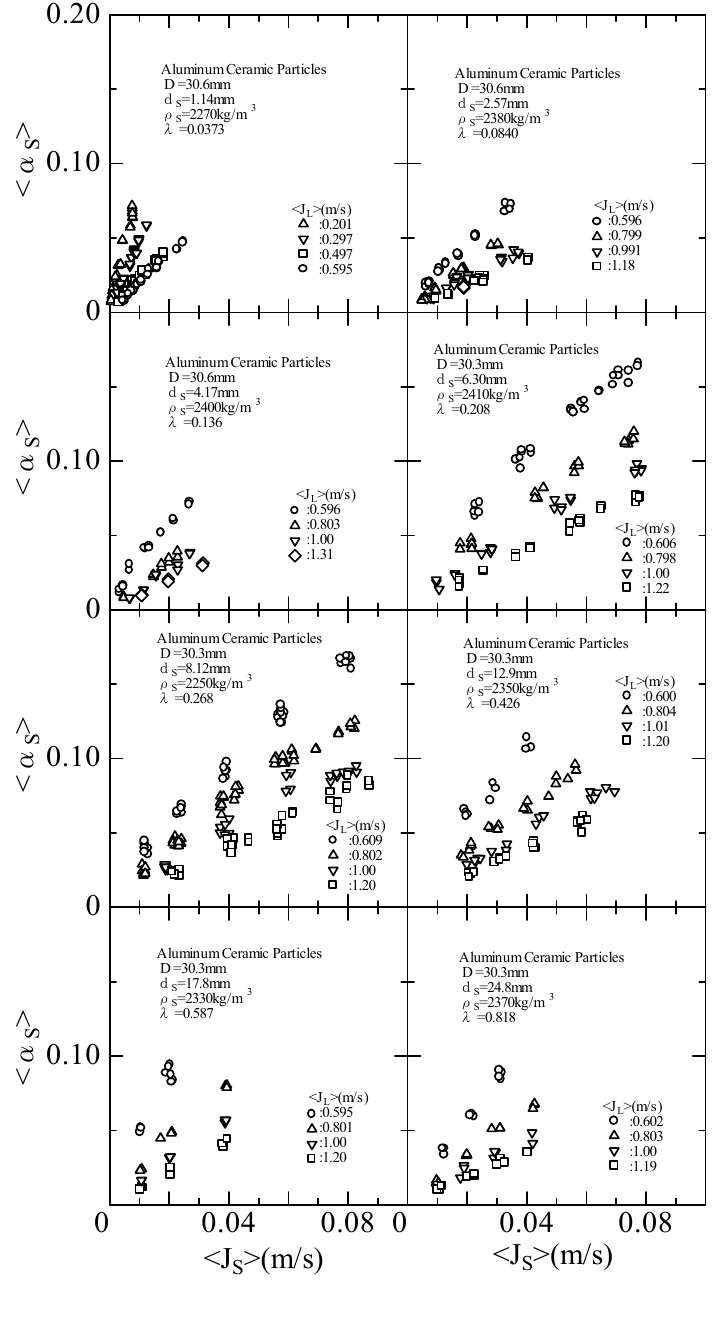
Fig.1 Solid volume fraction of solid-liquid two-phase flow with respect to < J